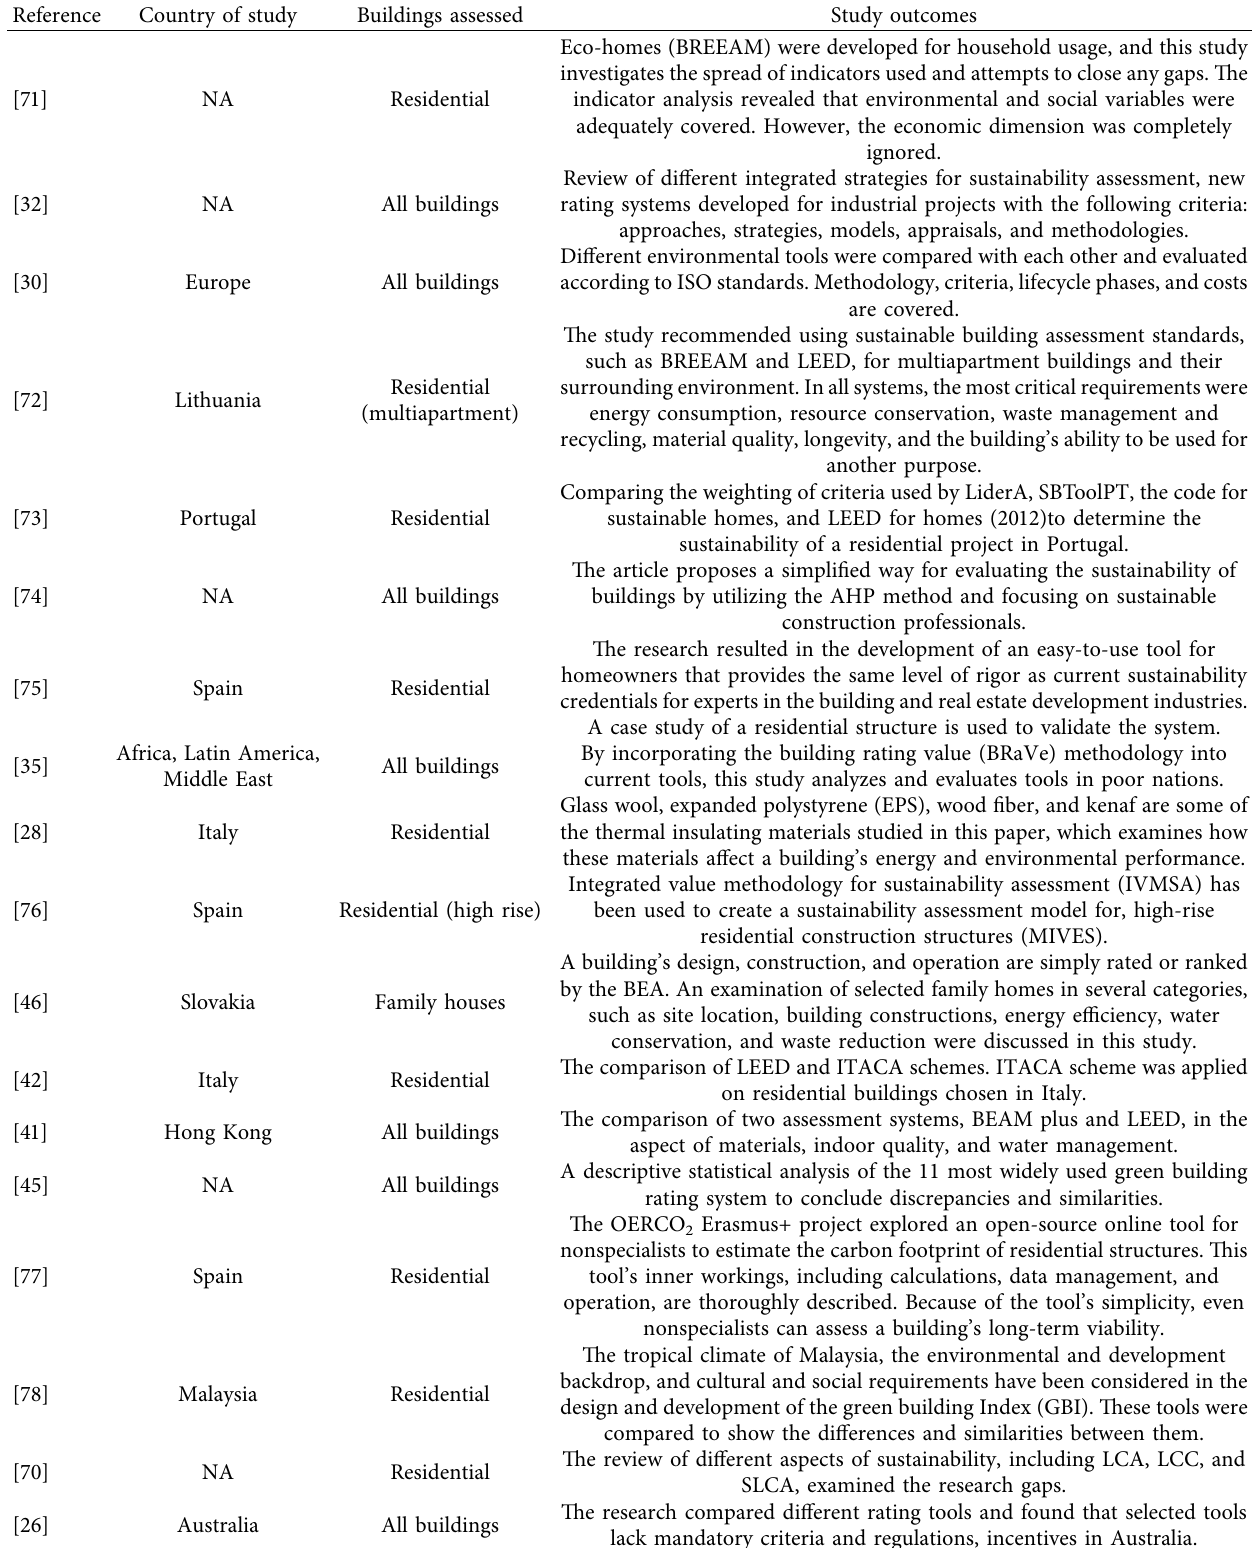
Table 4: Review of building environmental assessment from previous